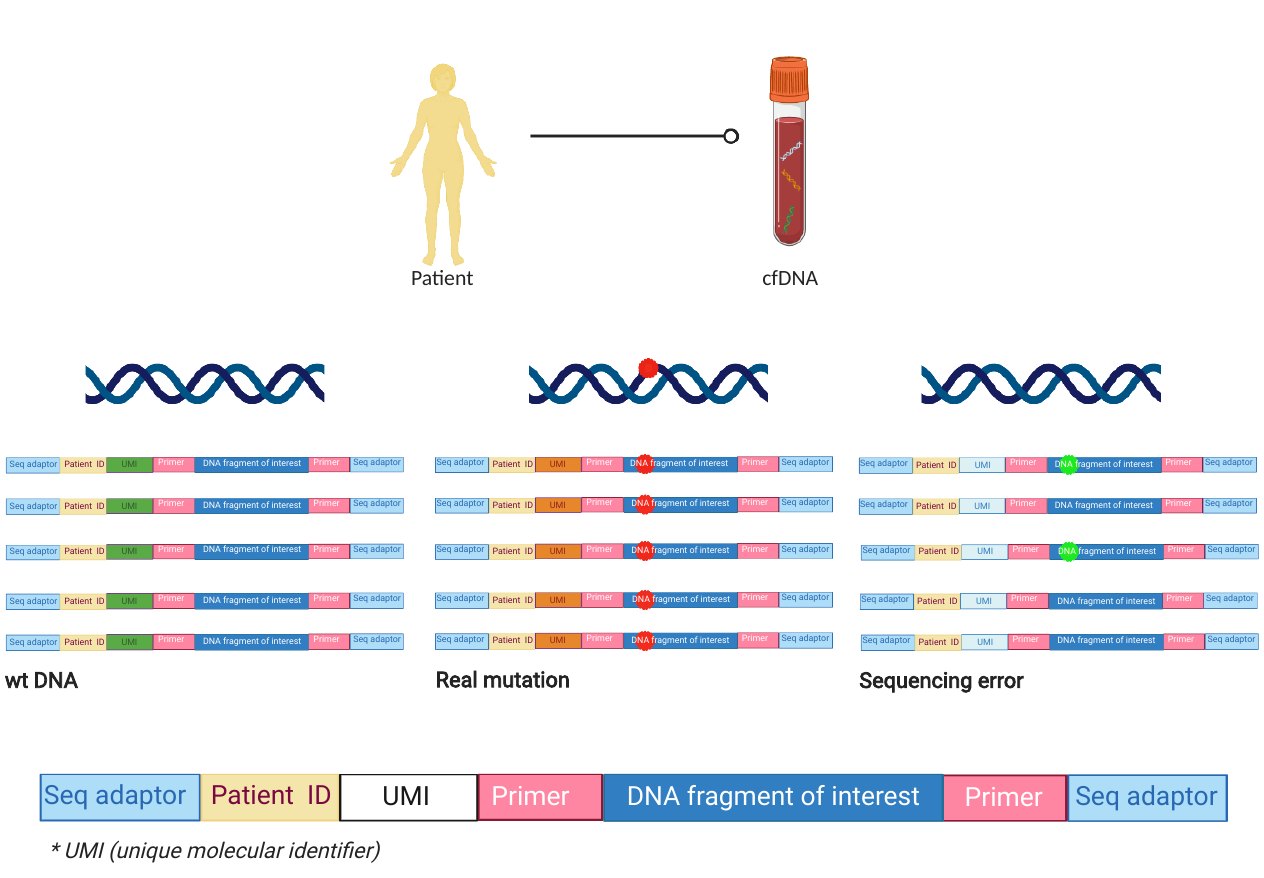
Figure 1. Preparation of sequencing libraries using ID barcodes and unique molecular identifiers (UMI). After the area of interest is selected, the ID barcodes specific to each patient are added to enable to analyze multiple patients in the same assay. After that, UMIs are added to each molecule during library preparation so that sequencing reads originating from the same starting molecule of each patient included in the library can be identified. This approach increases the assay sensitivity in terms of detecting sequencing errors. In the right sequence corresponding to the blue UMI, the alteration is objectified in only 2 of the amplifications, so it is assumed a sequencing error. In the middle sequence corresponding to the orange UMI, the mutation is found in all the amplifications so it is assumed a real mutation. In the left sequence, there is no mutation founded in any of the reads, so it is a wt ctDNA molecule. cfDNA: cell free DNA; wt: wild type; ID: identification; * UMI: unique molecular